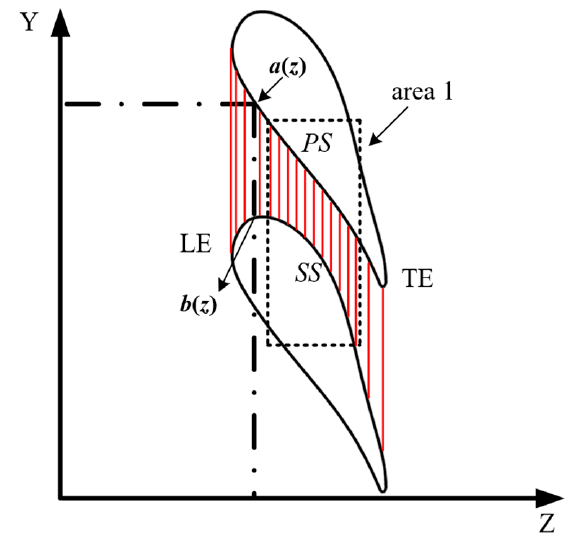
Figure 4. Distribution of asymmetric control lines on the end wall. 1 is modeled by the half-cycle circumferential control function ( X 1 ( y , z ) ), Case 2 is modeled by local contouring at 10%-to-100% C ax via the half-cycle circumferential control function ( X 1 ( y , z ) ). Case 3 and 4 are the result of X 2 ( y , z ) and X 3 ( y , z ) , respectively. Figure 6 shows the local grid diagram with a non-axisymmetrical endwall.